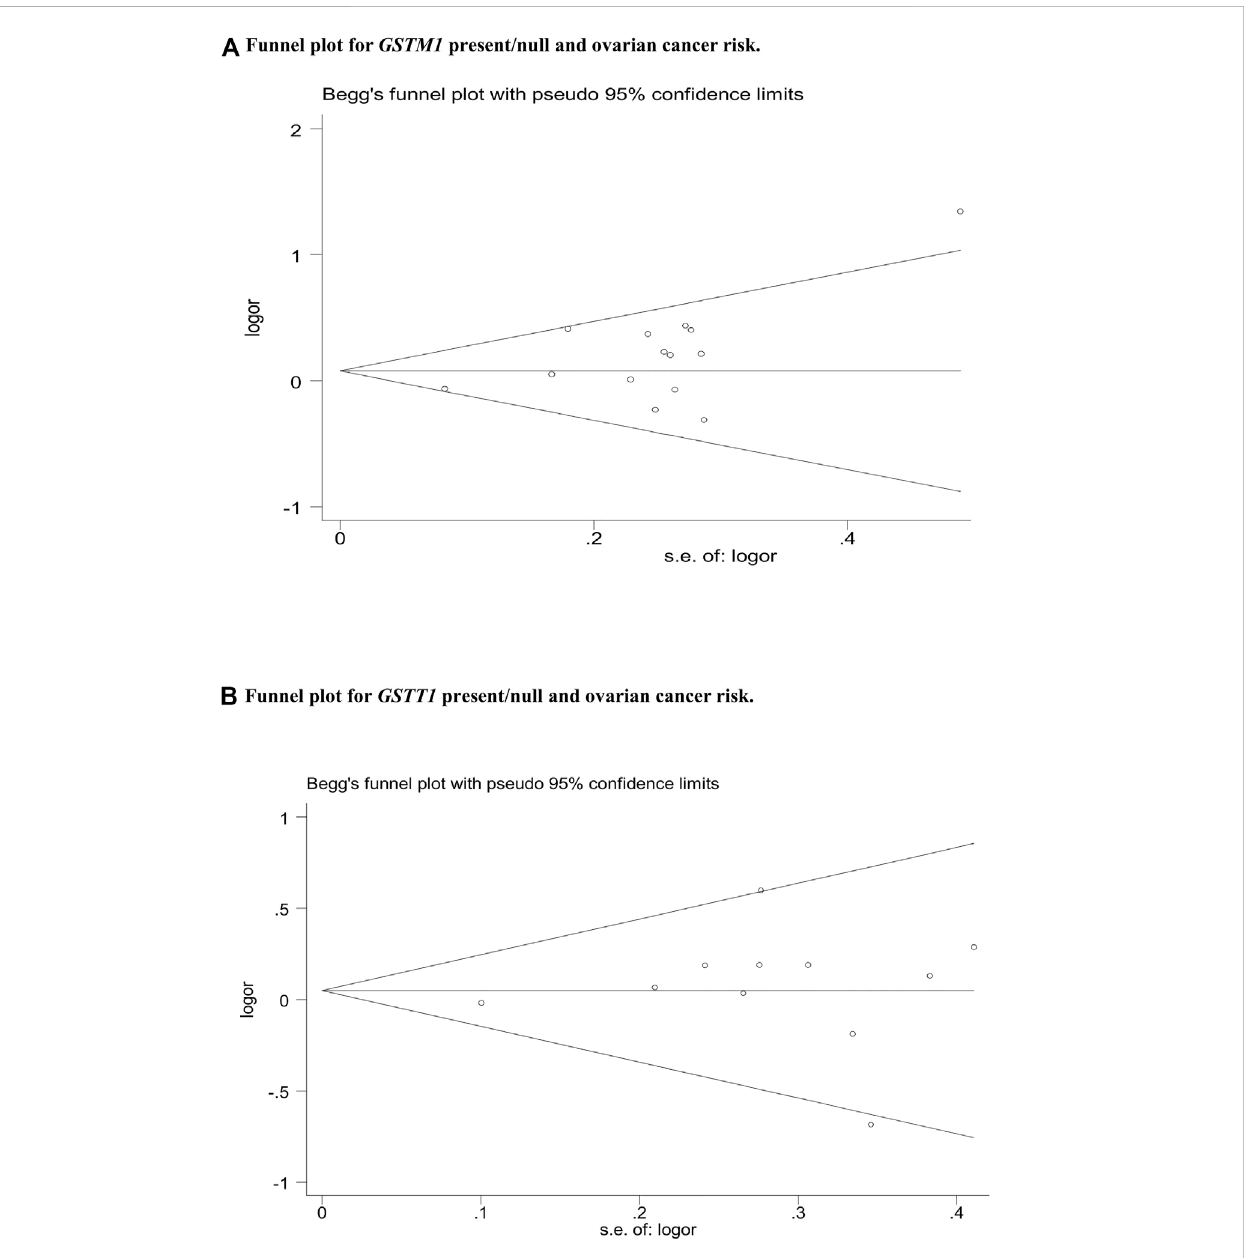
FIGURE 7 (A) Funnel plot for GSTM1 present/null and ovarian cancer risk. (B) Funnel plot for GSTT1 present/null and ovarian cancer